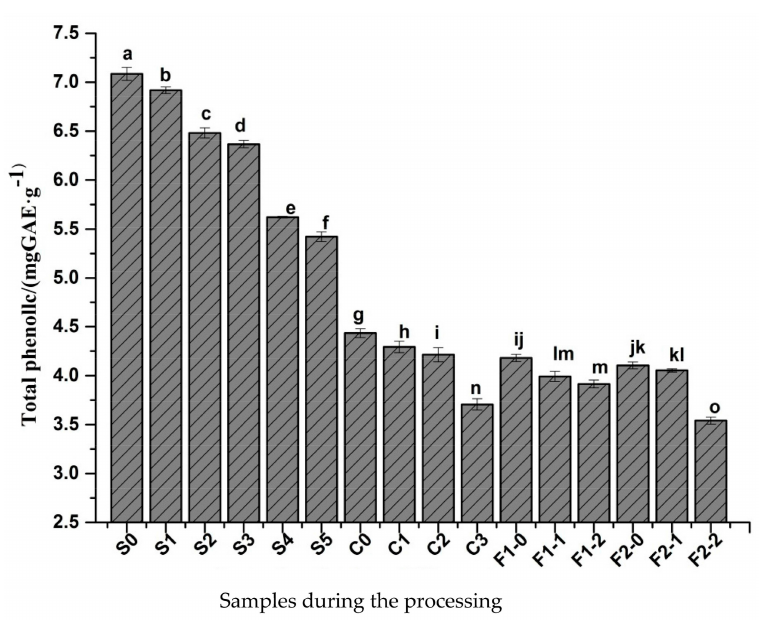
Figure 2. Changes in the total phenolic content during the preparation of black pepper. Different letters (a, b, c, and so on) on the columns indicate significant differences between the samples ( p < 0.05). Data are means ± standard error of mean. The meaning of S0, S1, and other samples is provided in Table 1. It is also possible that some polyphenols were lost when the berries were blanched. In this study, we observed that the black pepper was blacker in color and more uniform after the heat treatment than the direct sun drying. As to the samples of the after one-day sun drying before mild fermentation and two-day sun drying before mild fermentation, the total phenolic content decreased by 2.56%